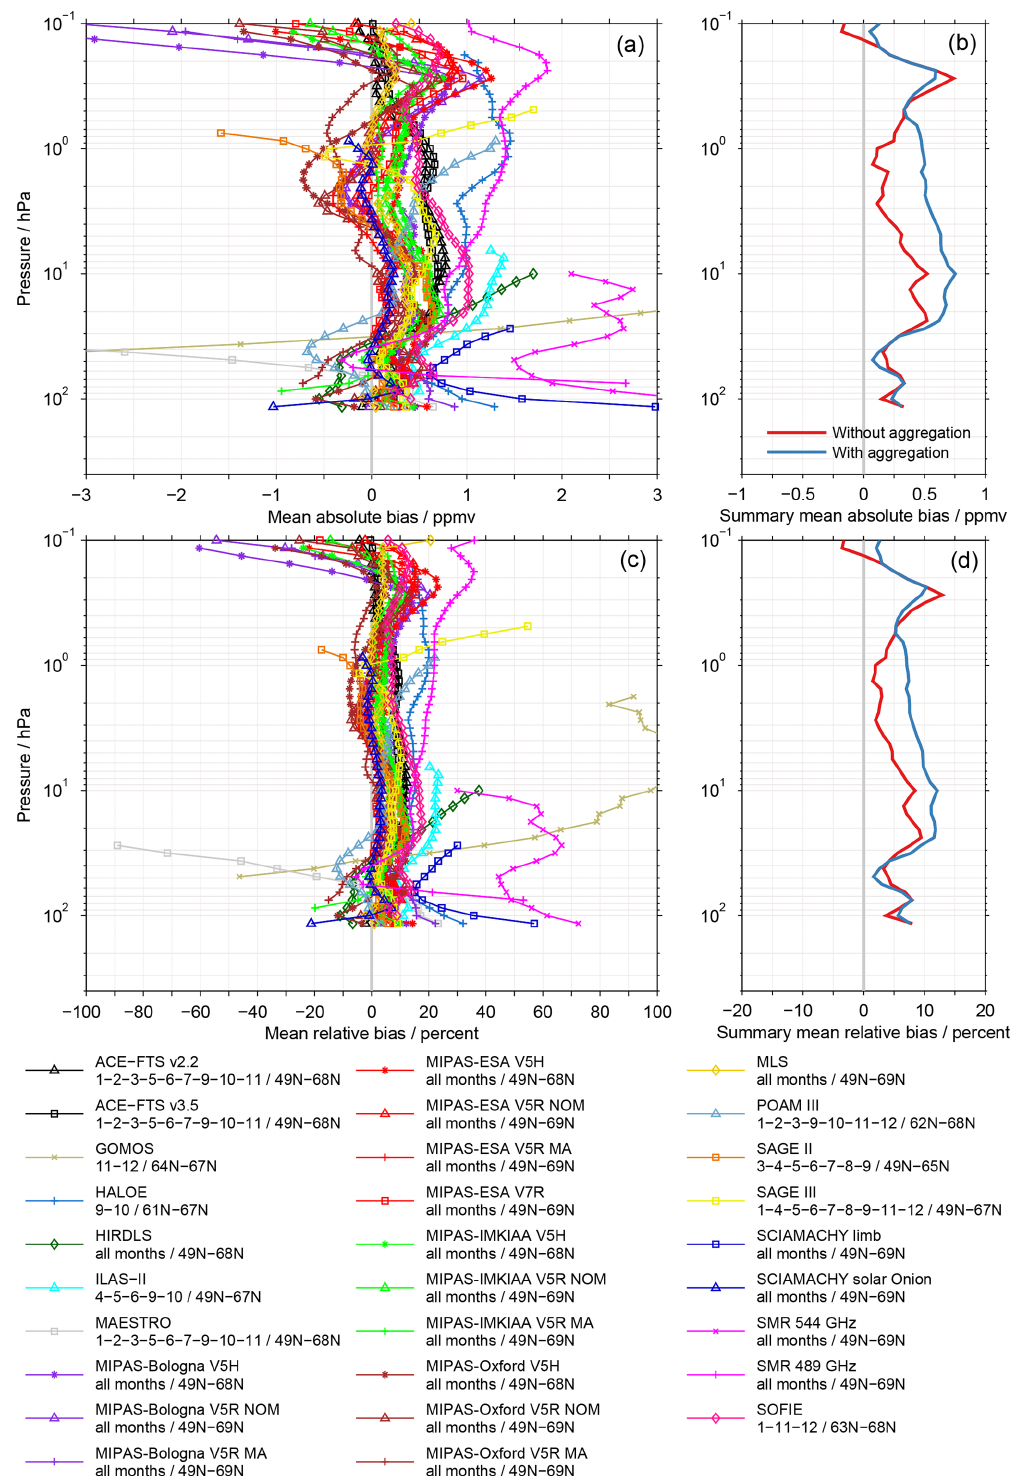
Figure 4. Biases of the SCIAMACHY solar OEM data set in absolute (a, b) and relative terms (c, d) . These example results are based on coincident observations during all seasons and at all latitudes. Panels (a) , (c) show the mean biases to the individual data sets, as listed in the legend. In addition, the legend provides information on the temporal and spatial coverage of the individual comparisons. Panels (b) , (d) provide a summary of the bias results. The red profile is based on the median over all comparisons, while the blue profile considers the aggregation of MIPAS results as described in Sect. 3.5. The latter profile is used in Sect 4.3 and in the Supplement to summarise the bias results for the individual data sets. For better visibility only results at every second altitude are plotted (see Sect.